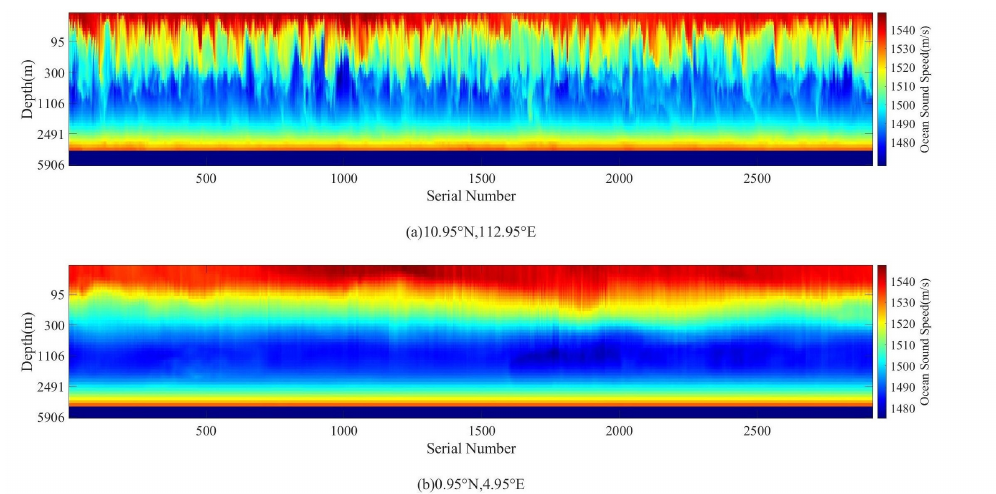
Figure 4. Schematic diagram of the SSP of the two coordinate points (the total time of 1 year and the sampling interval of 3